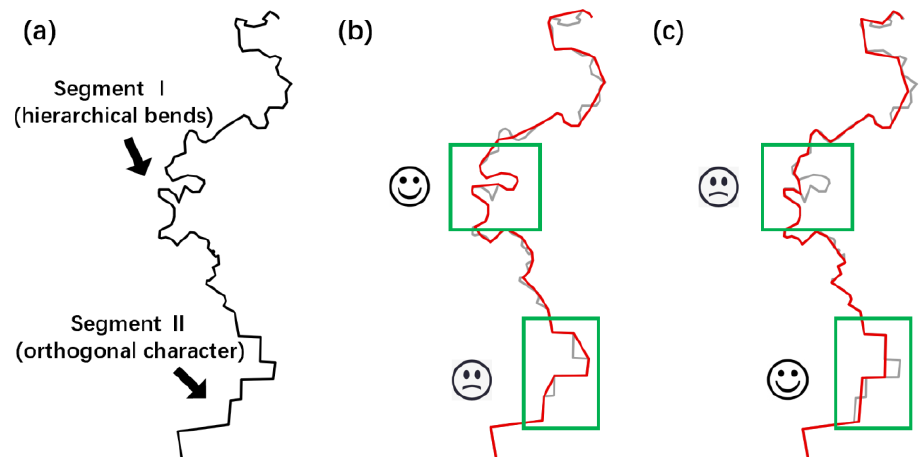
Figure 1. Simplified results (in red) of a line with different shape characteristics using two different algorithms: ( a ) the original line; ( b ) result using the bend-based simplification algorithm; ( c ) result using the orthogonality-preserving simplification algorithm.